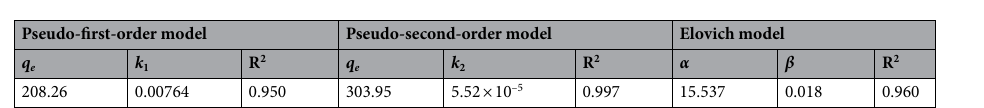
Table 2. The adsorption kinetic parameters of the adsorption of uranyl ions by ZnNiAl-LDHs. The units of q e (mg/g), k 1 (min −1 ), k 2 (g/(mg·min)), α (mg/g × min), β (mg/g).